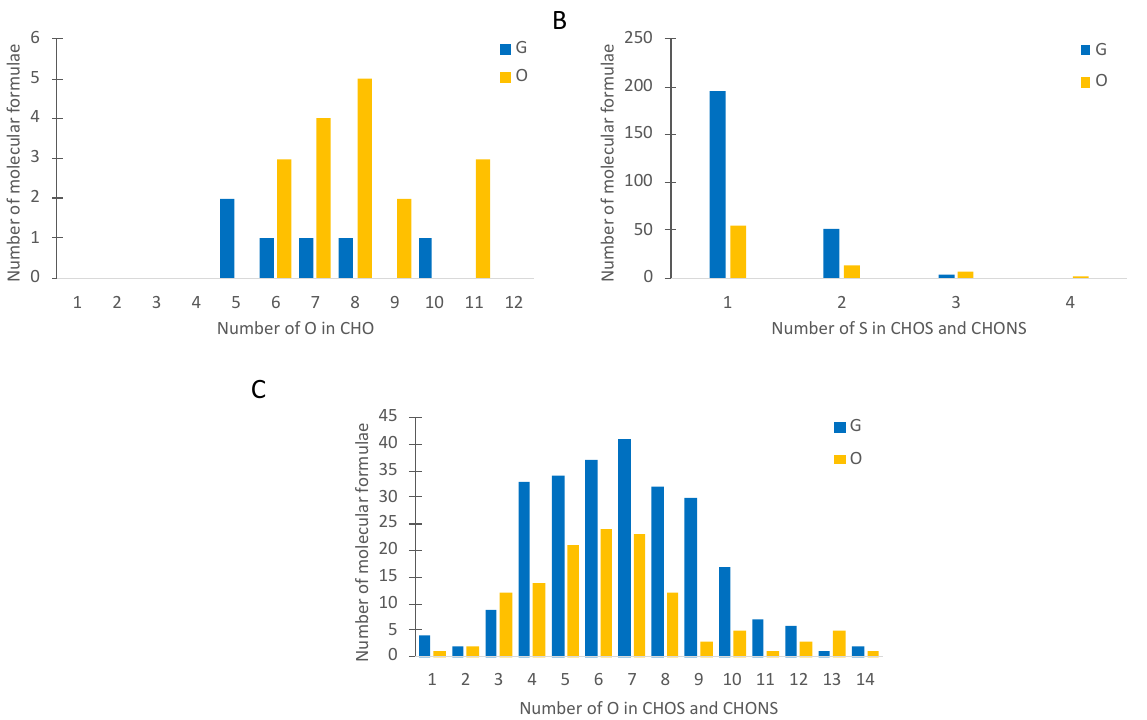
Figure 3. Counts of elemental formulas for both good (G) and oxidized (O) wines, with increasing numbers of O atoms in CHO ( A ), with increasing numbers of S atoms in CHOS and CHONS ( B ), and with increasing numbers of O atoms in CHOS and CHONS ( C ).